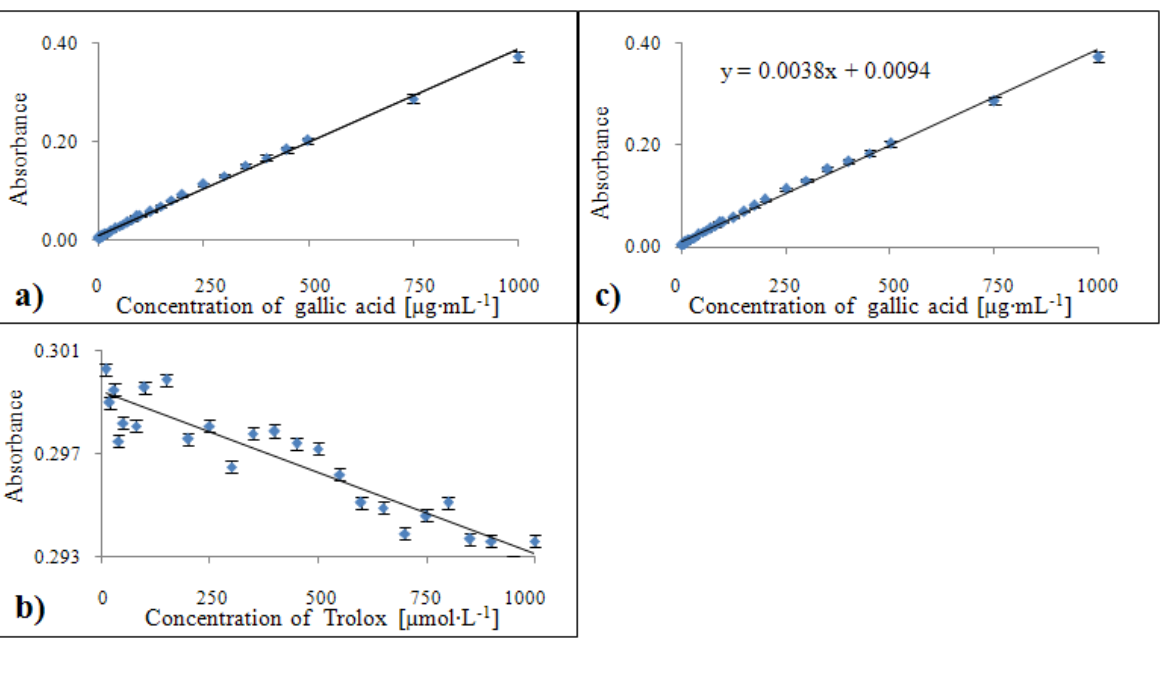
Figure 11. Dependences of absorbance of colour product on concentration of gallic acid (a) and Trolox ® (b) . Calibration curve for the Free radical method related to equivalents of gallic acid (c) , expressed in units of